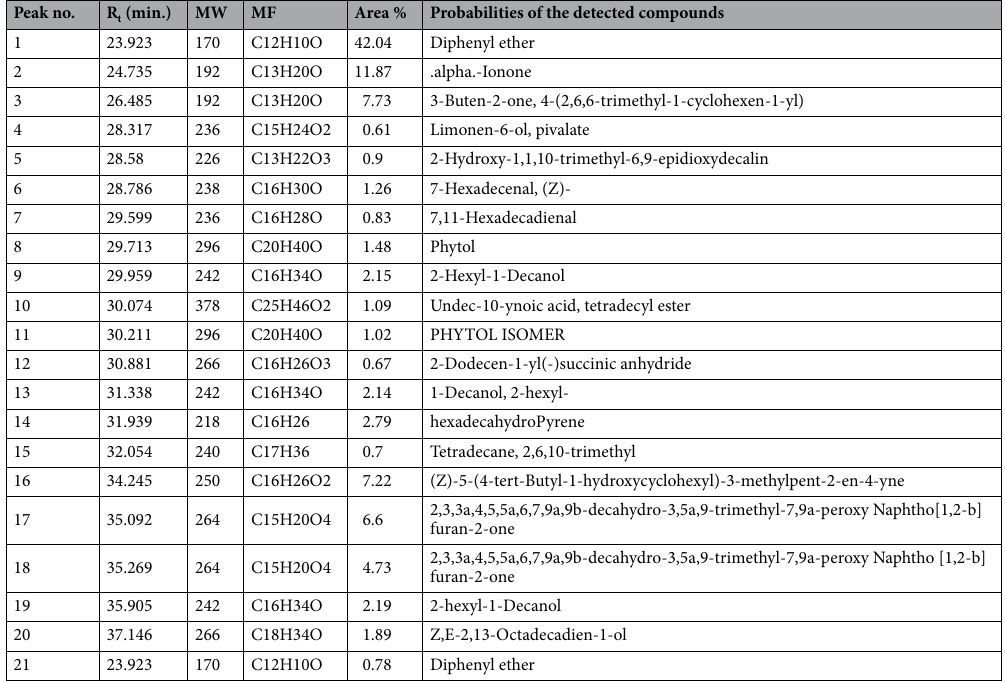
Table 9. GC/MS analysis of the Viola odorata